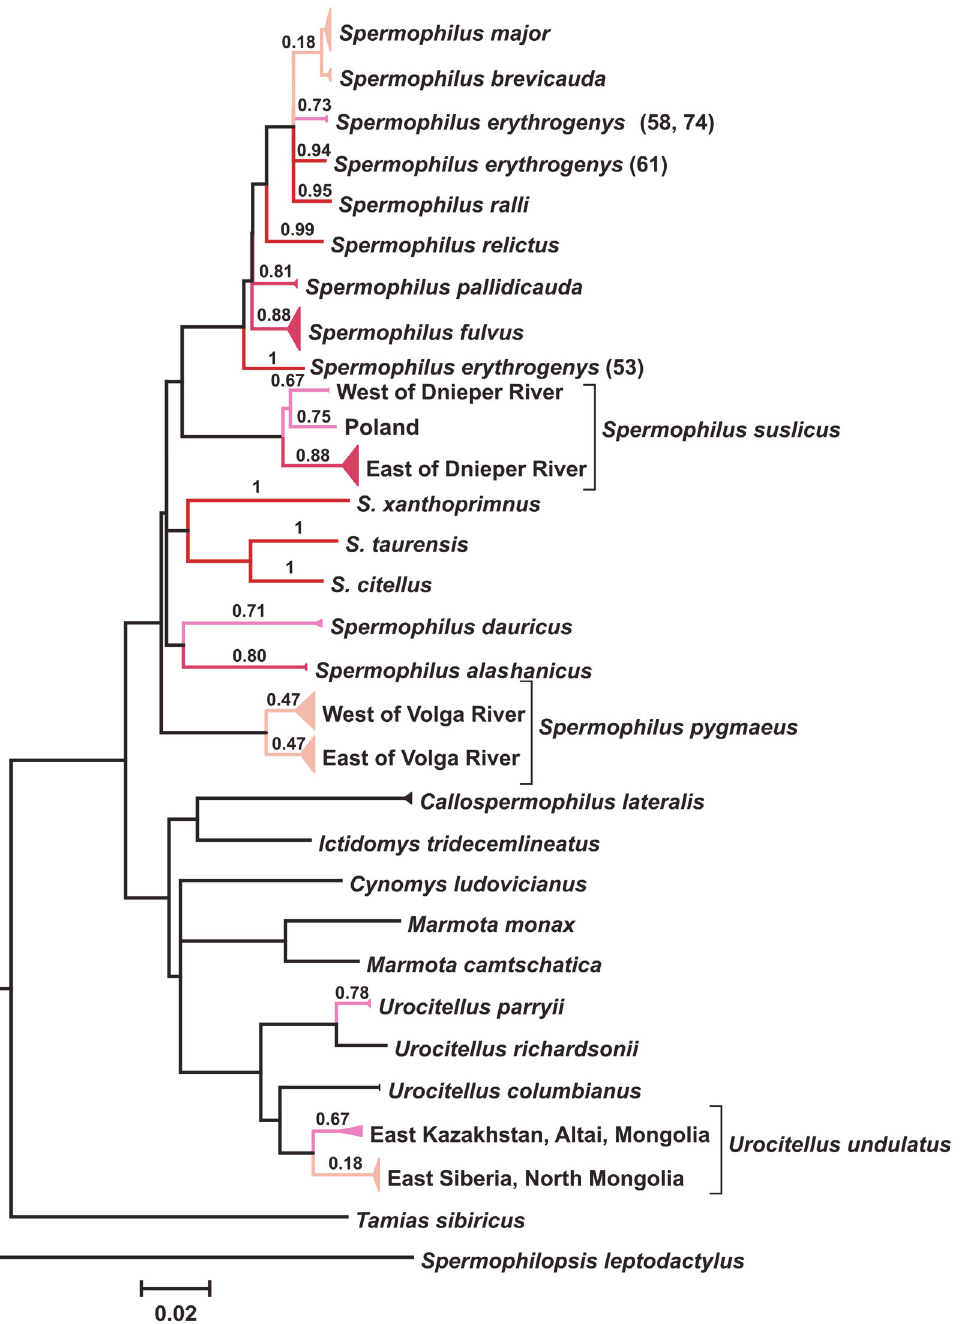
Figure 5. Species delineation of Eurasian ground squirrels by Poisson tree processes (PTP) on the ML tree (HKY+I+G model; 657 bp of COI). Bayesian support values for delimited species are indicated;intensity of red color reflects the strength of support. The nodes with multiple specimens were collapsed to a triangle, with the horizontal depth indicating the level of intraspecific divergence. Individuals with introgressed mtDNAare not included into the tree.